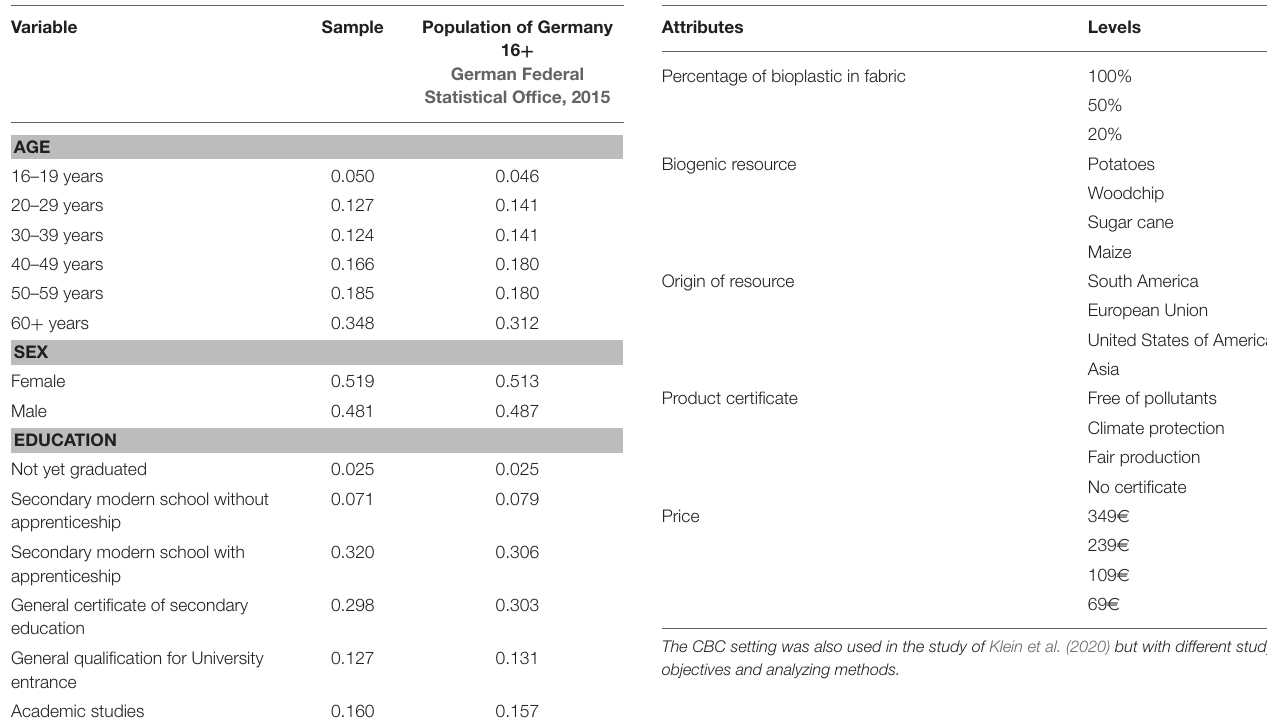
TABLE 2 | Sociodemographic data of the sample. TABLE 3 | Attributes and levels of the choice-based conjoint